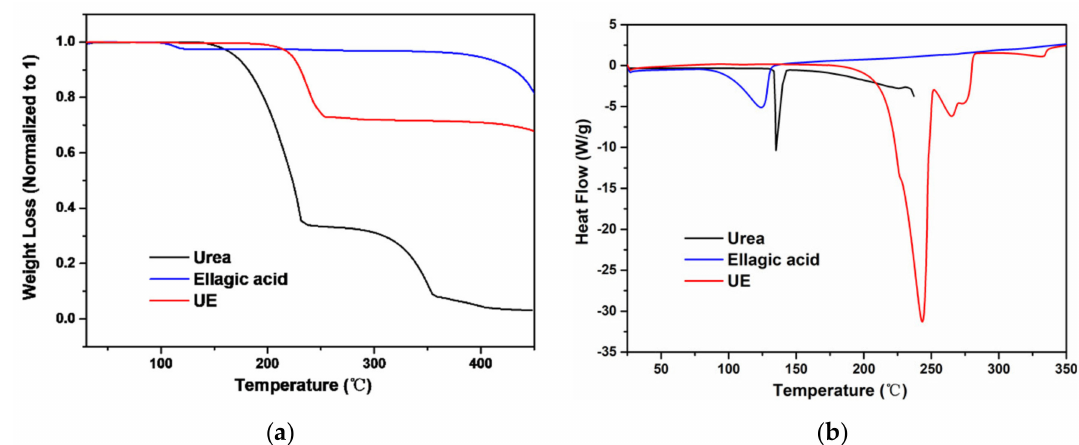
Figure 10. ( a ) TGA curves of urea, ellagic acid and UE. ( b ) DSC curves of urea, ellagic acid and UE.